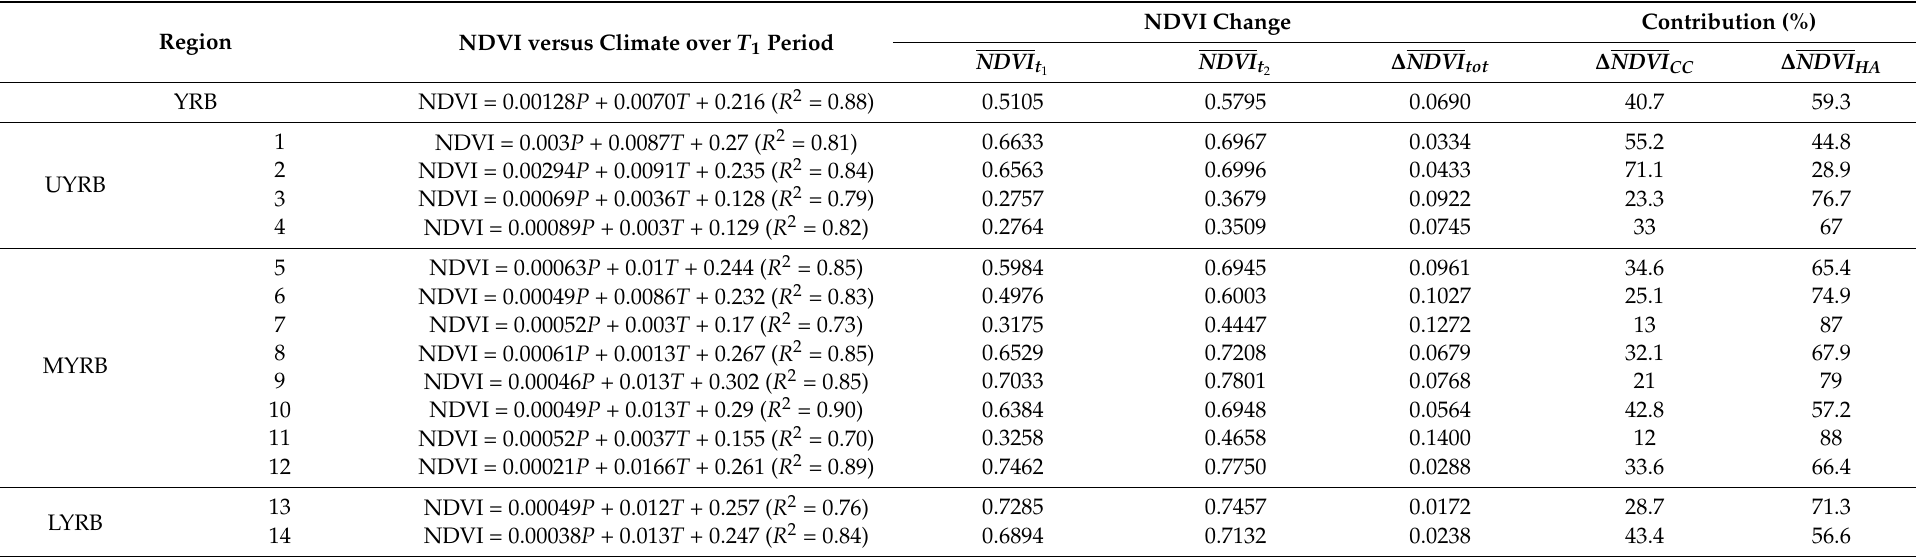
Table 5. Quantitative analysis of the YRB and